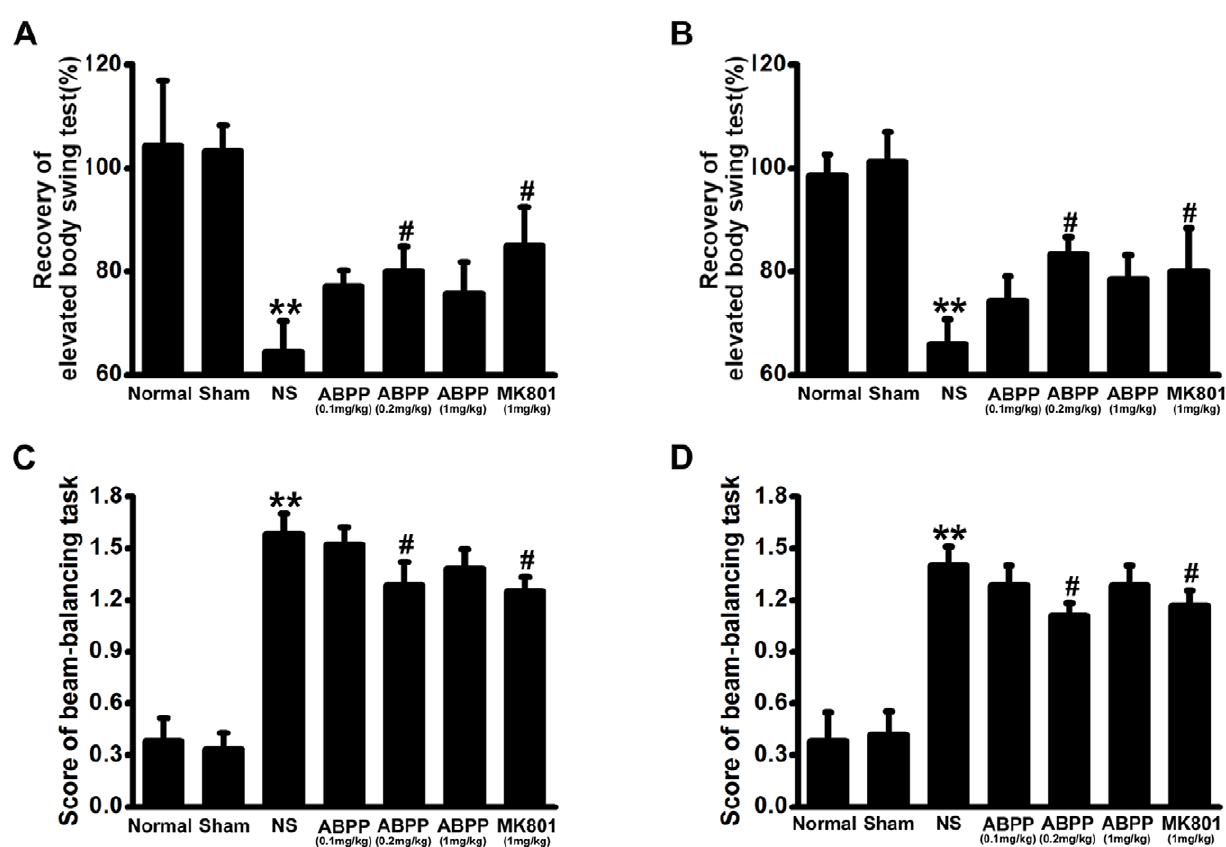
Figure 3. Effect of ABPP on the elevated body swing test and the score of beam-balancing task. Systemic administration of ABPP improved asymmetric motor behavior at 7 th (A) and 30 th day (B) after MCAO. Treatment with ABPP reduced the beam-balancing task score at 7 th (C) and 30 th day (D) too. Data are expressed as means 6 SEM (n=8); ** P , 0.01, compared to the Sham group; # P , 0.05, compared to the NS group.